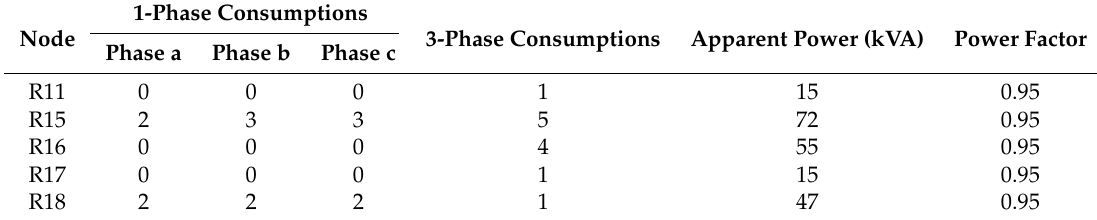
Table 2. Household distribution for the test